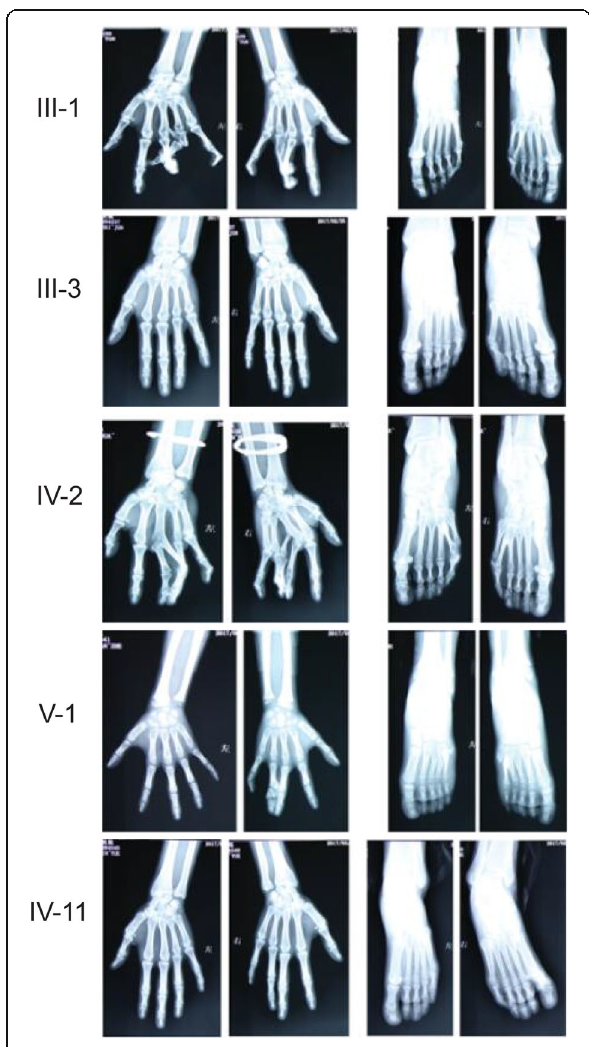
Fig. 3 Radiographs of the affected members of the family in which hand and foot deformities are clearly